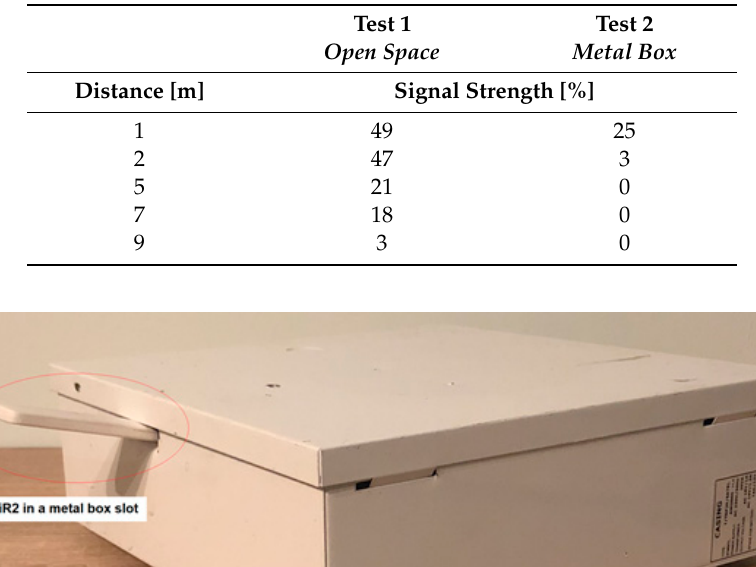
Table 3. The results of the AP strength signals during the tests 1 and 2.